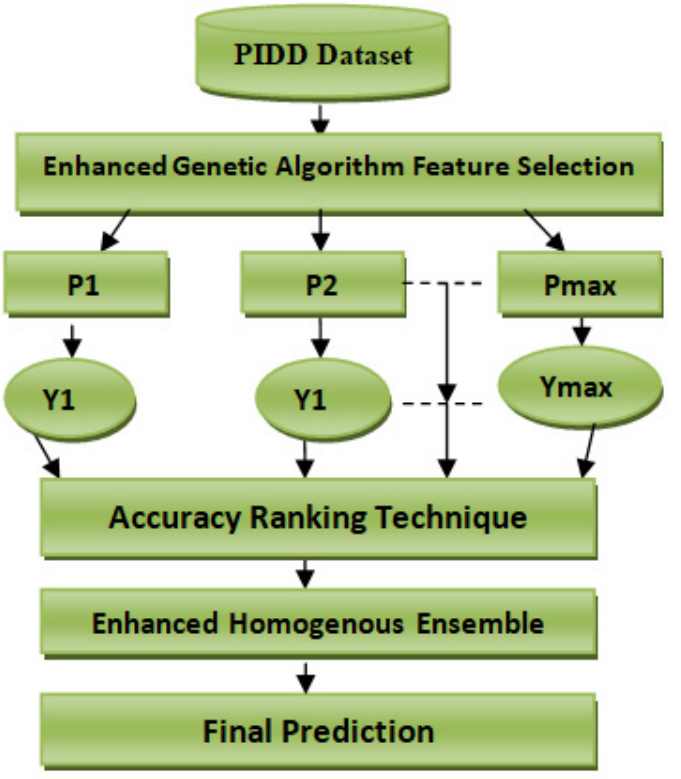
Figure 1. Proposed Scheme.